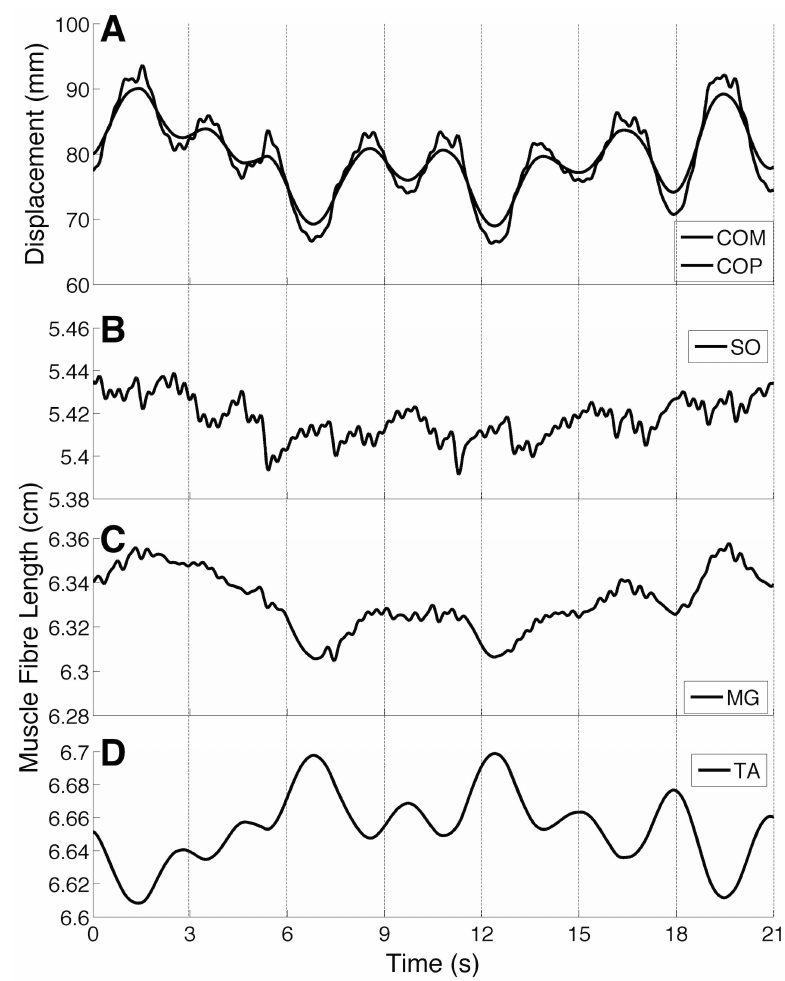
Figure 7. Modulation of muscle fibre lengths during postural sway (typical simulation performed on Model2 ). (A) Centre of mass (COM; gray curve) and centre of pressure (COP; black curve) displacements. (B-D) Muscle fibre lengths from Soleus (SO), Medial Gastrocnemius (MG), and Tibialis Anterior (TA) muscles. Lateral Gastrocnemius (LG) was not shown here because its behaviour is quite similar to that of the MG muscle. Dashed lines represent the 3-s duration windows used to perform the correlation analysis between COM and muscle fibre lengths (see Methods for details and Figure 8).